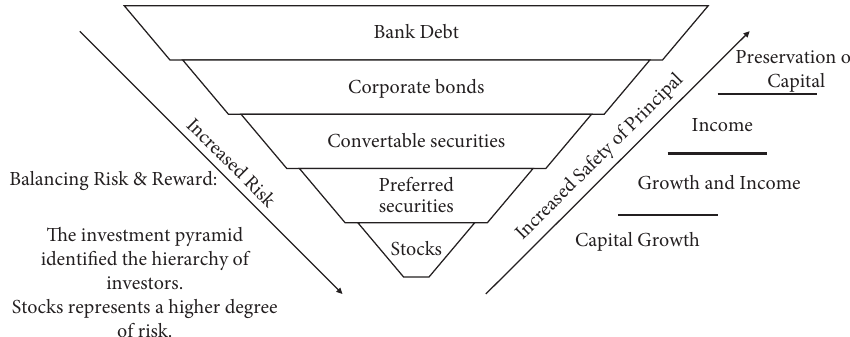
Figure 2: The investment pyramid identified the hierarchy of investors.